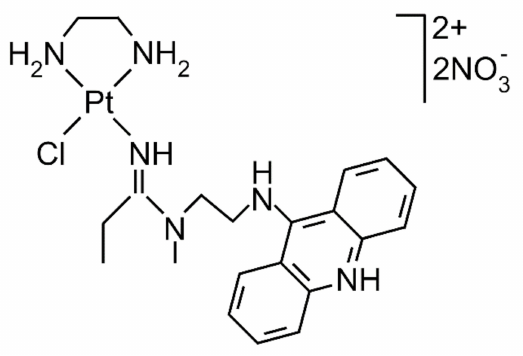
Figure 1. Structure of the investigated platinum complex